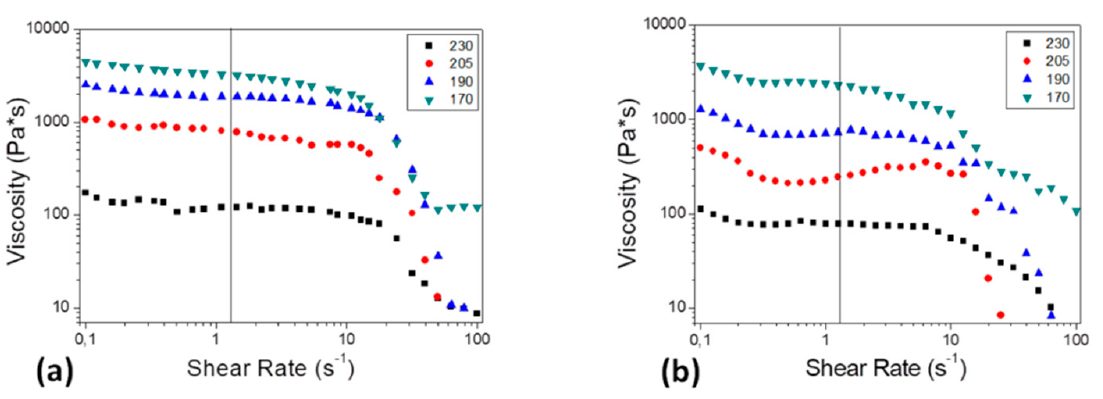
Figure 5. Viscosity vs. shear rate at different temperatures of interest for ( a ) neat PDMS and ( b ) composite Na–CMC/PDMS filaments.